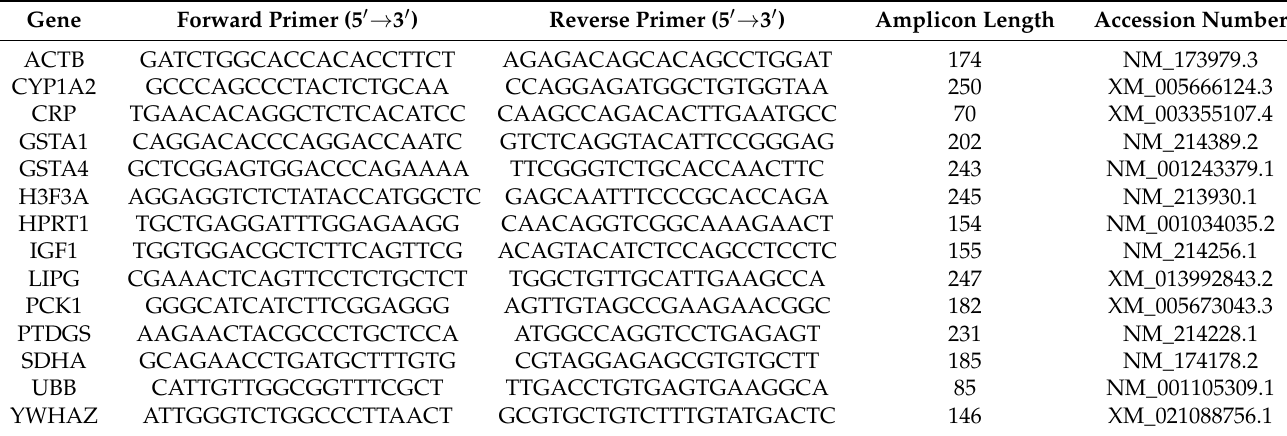
Table 2. List of primer